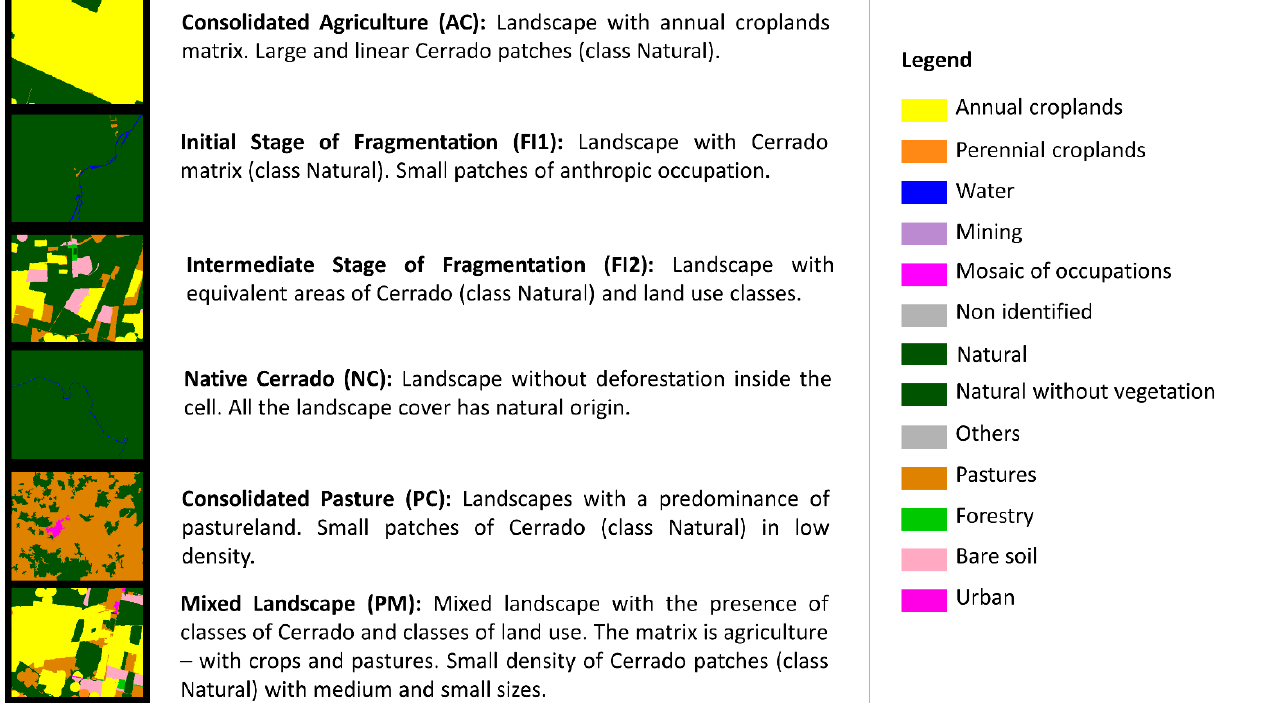
Figure 3. Landscape typology of patterns observed in the study region from the composition and arrangement of TerraClass Cerrado land use and land cover patterns.